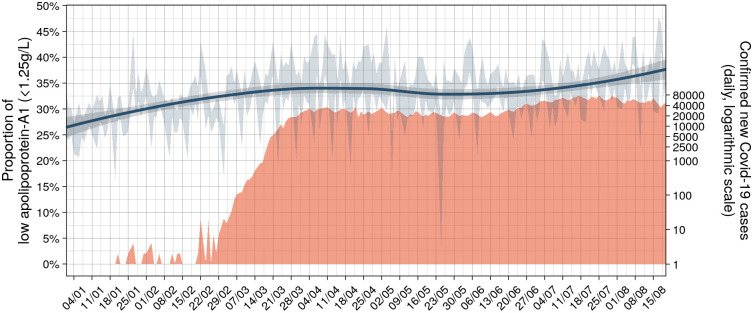
Number of confirmed Covid-19 cases per day and proportion of low (<1.25g/L) apolipoprotein-A1 in the US cohort during the first 34 weeks of 2020.The red graph is the number of confirmed cases per day in logarithmic scale. The black line is the daily mean proportion of low apolipoprotein-A1 (<1.25g/L; blue line;95%CI in grey).